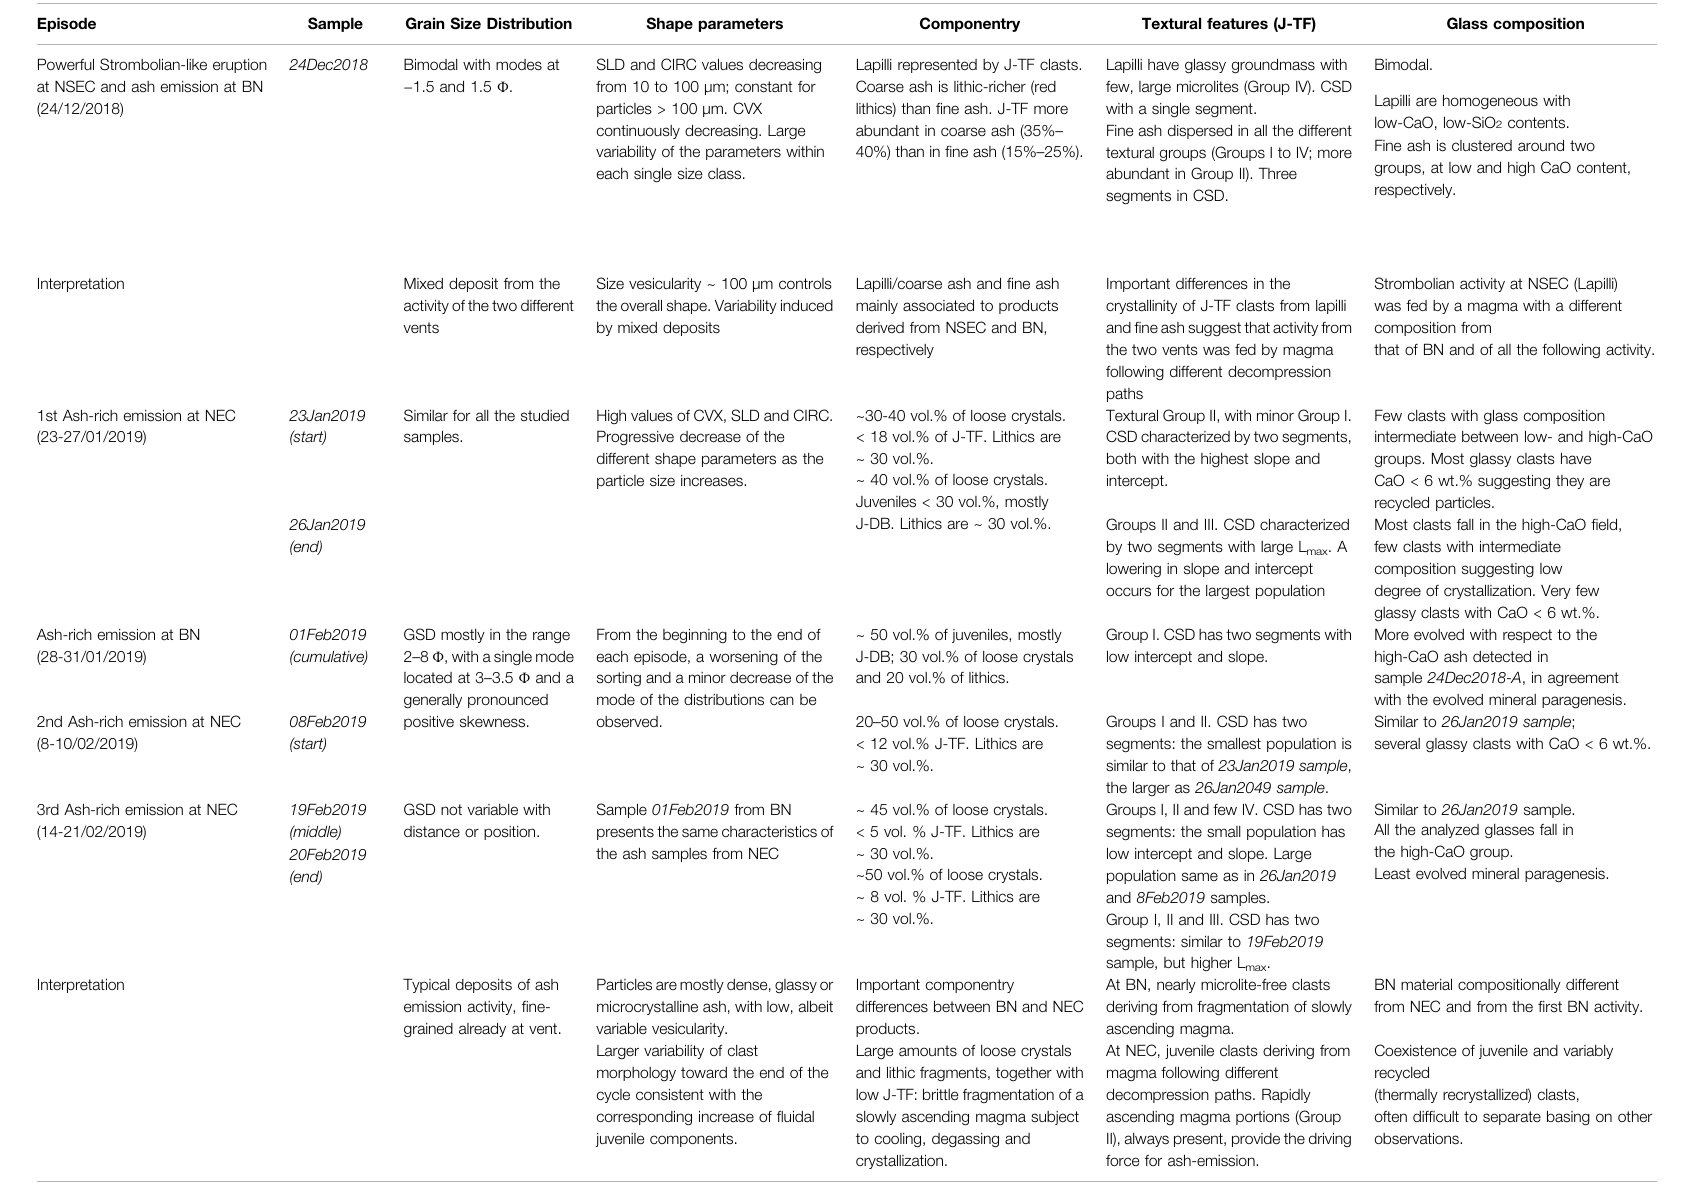
TABLE 3 | Summary table of all the results and their meaning, obtained from each studied